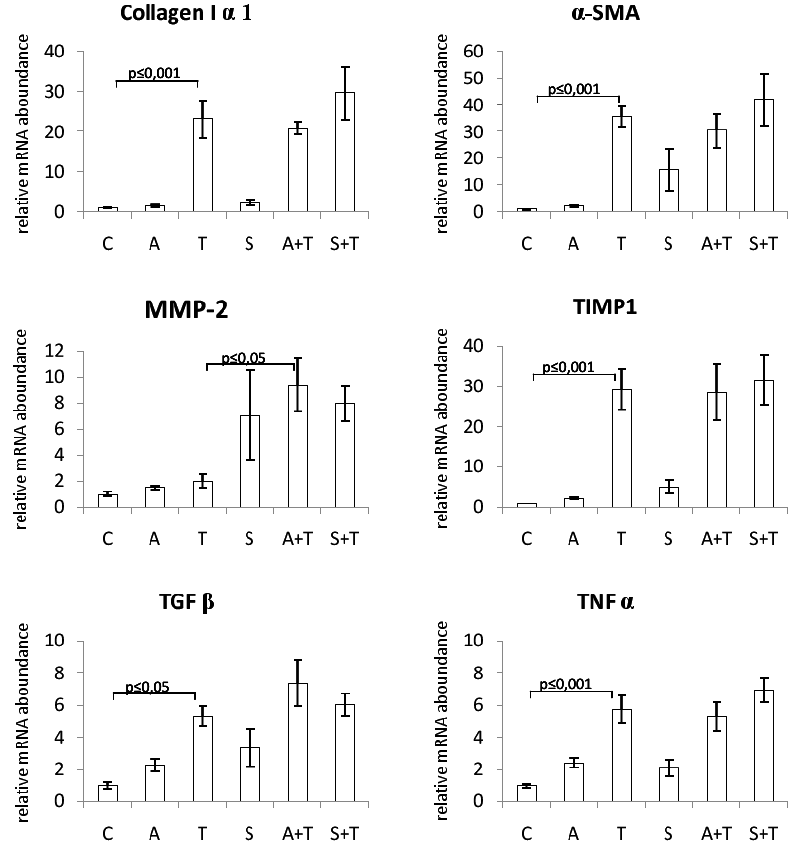
Figure 2. Effect of chokeberry juice or silymarin on the expression of fibrosis-related genes in the liver of rats treated with CCl 4 . Treatment groups: (C) controls; (A) chokeberry juice; (T) CCl 4 ; (S) silymarin; (A + T) chokeberry juice + CCl 4 ; (S + T) silymarin + CCl 4 .